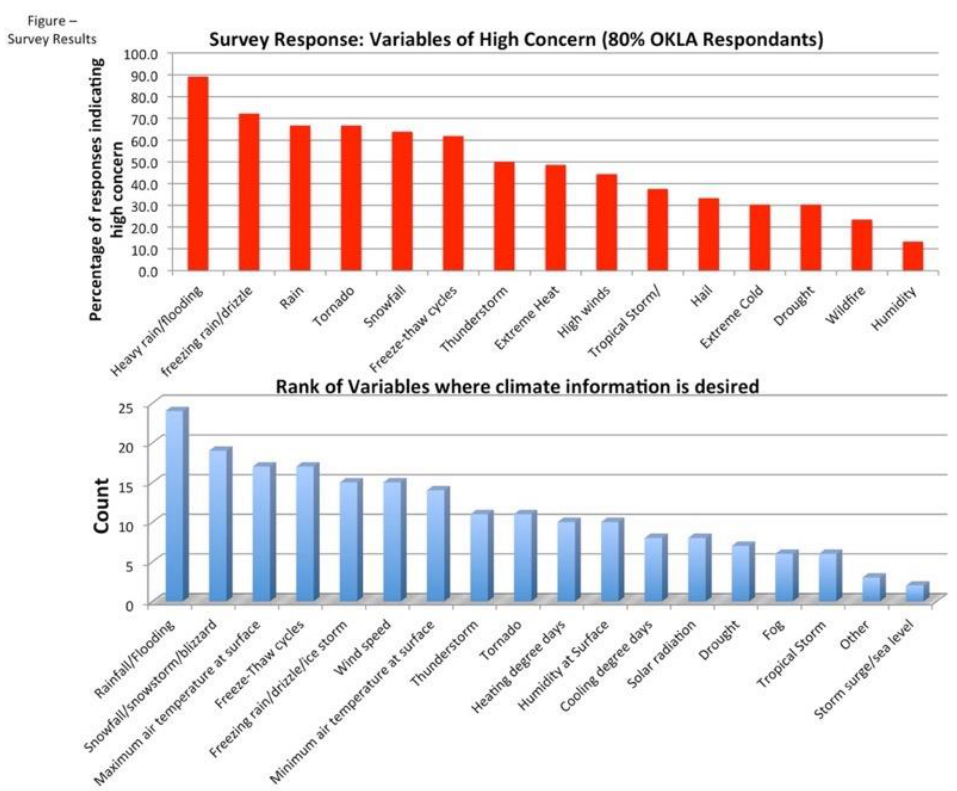
Figure A1. Ranks of weather/climate variables of concern (top; percentage of responses indicating high concern) and information need (bottom; number of participants who selected listed options) drawn from survey responses. Participants could select multiple answers.